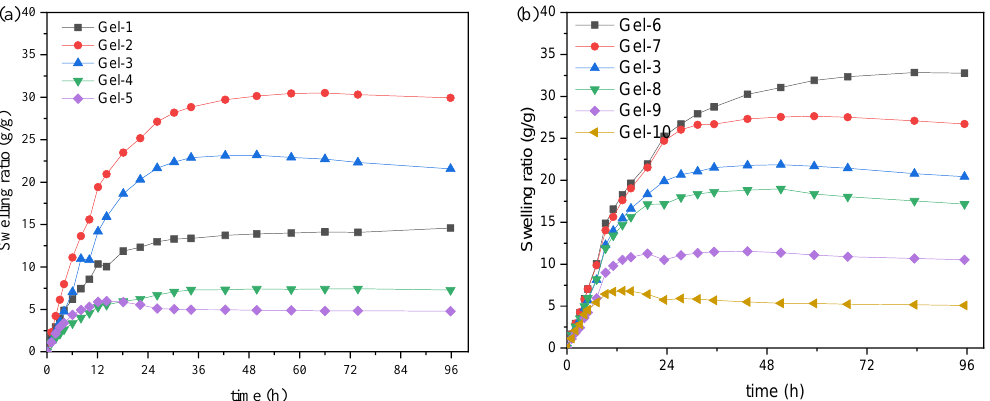
Figure 3. Variation of swelling ratio of P(AAc-co-Am)/PVA double network hydrogels as function of time at 37 ℃ : ( a ) hydrogels with various Am/AAc ratios; ( b ) hydrogels with various Fe 3+ concentrations.